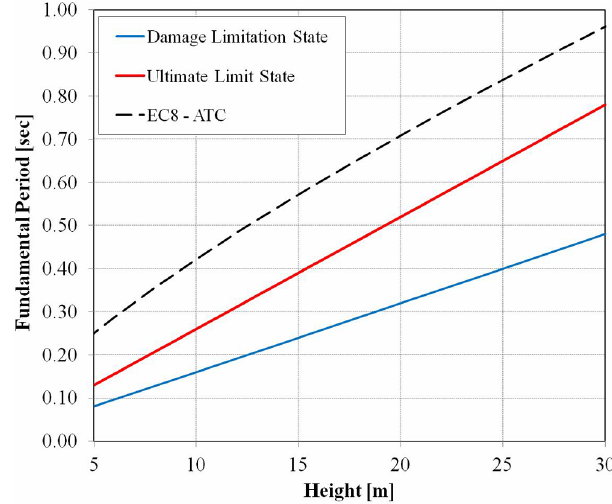
Fig. 7. Height–period relationship for different damage levels and comparison with code formula.